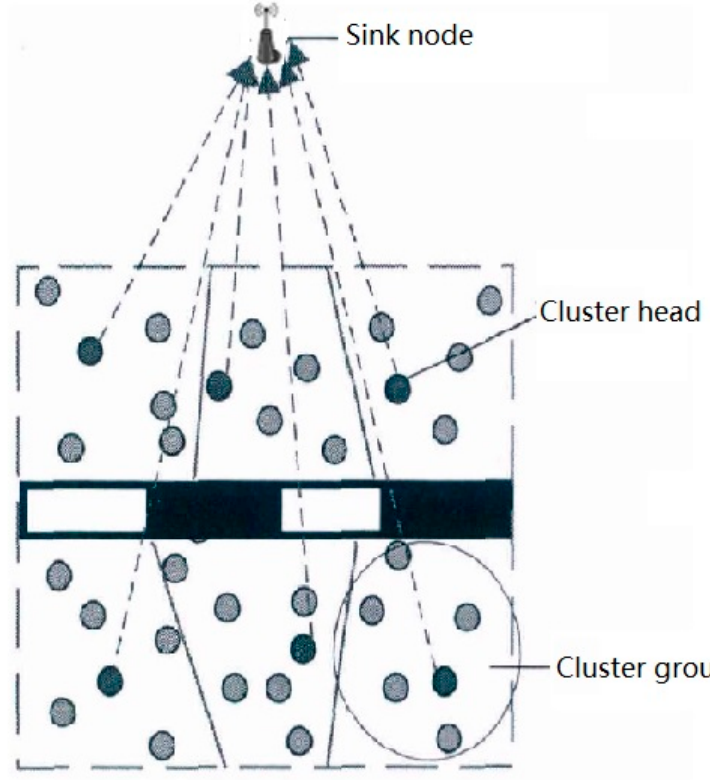
Figure 2. Structure of sub-monitoring area.